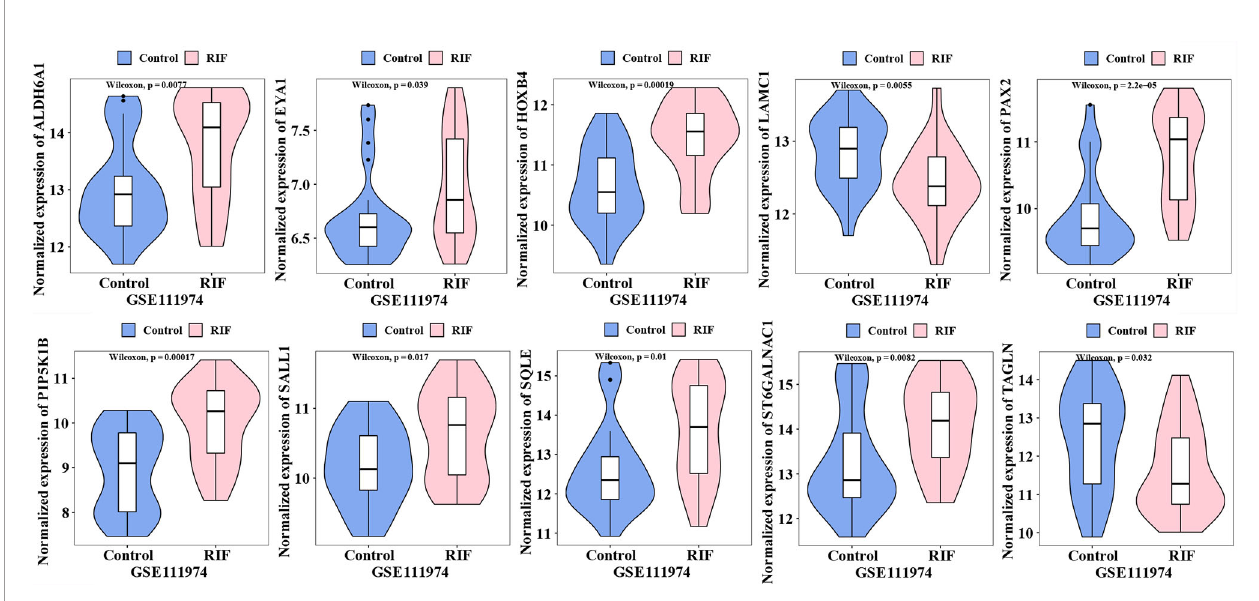
FIGURE 6 | The normalized expression of hub genes validated in